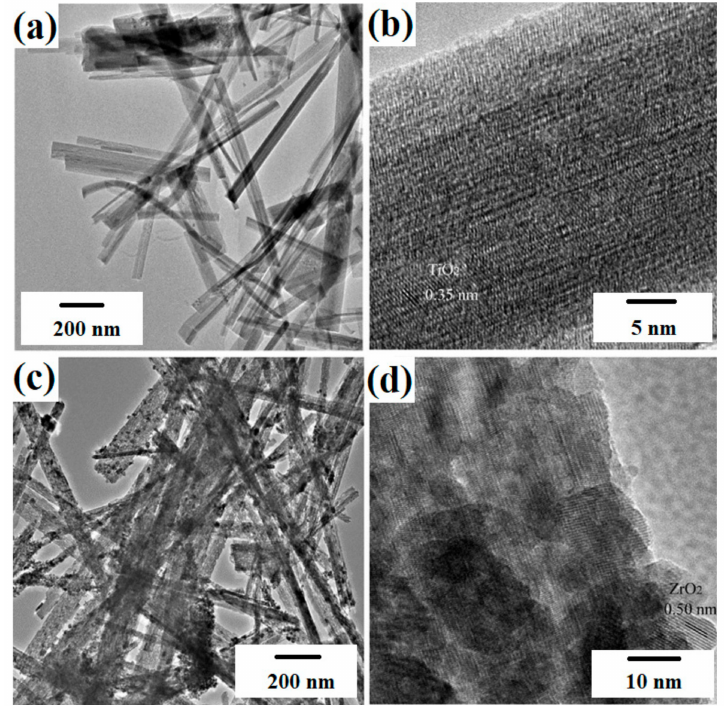
Figure 4. TEM images of ( a ) TiO 2 ; ( b ) TiO 2 -ZrO 2 ; HRTEM images of ( c ) TiO 2 and ( d ) TiO 2 -ZrO 2 (created based on [82] with permission from Elsevier